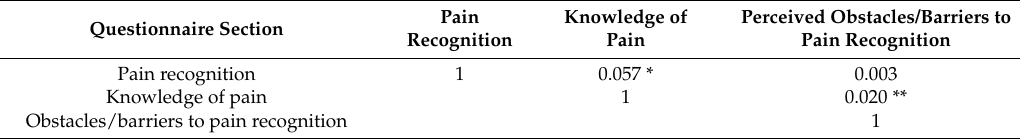
Table 6. Correlation between total scores of each of the three questionnaire